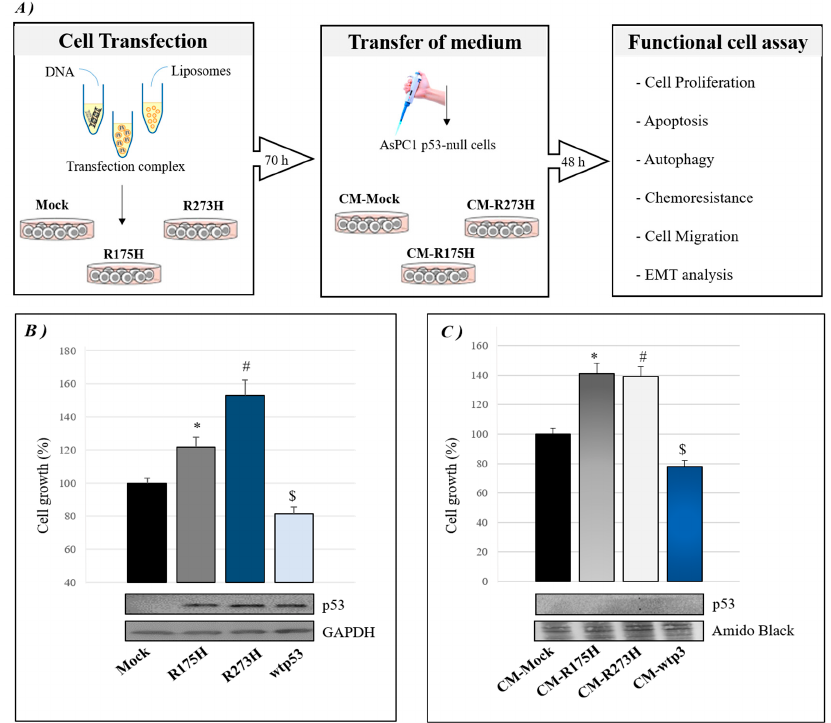
Figure 1. Cancer cell secretome driven by mutant p53 can induce hyper-proliferative effects. ( A ) A summary model of the approach used in this study: p53-null AsPC-1 cells were transfected with plasmids for R273H or R175H mutant p53 over-expression or its mock vector for 48 h. Then, AsPC-1 transfected cells were washed in PBS to remove liposomes and incubated with fresh culture medium for further 22 h to accumulate secreted proteins. After that, the conditioned medium (CM) of AsPC-1 transfected cells was transferred to untransfected p53-null AsPC-1 cells. After 48 h, several biological phenomena listed in the figure were investigated in AsPC-1 cells bearing mutp53-driven CM. ( B ) Cell growth was measured by Cristal Violet assay in p53-null AsPC-1 cells transfected for over-expression of wtp53, R175H or R273H mutp53. Accompanying Western blotting of p53 and of GAPDH for control loading are reported. Statistical analysis * p < 0.05 R175H vs Mock; # p < 0.05 R273H vs Mock; $ p < 0.05 wtp53 vs Mock. ( C ) Cell growth was measured by Cristal Violet assay in untransfected p53-null AsPC-1 cells cultivated with wtp53-, R175H- or R273H-CM. Accompanying Western blotting of p53 and amido black staining are reported. Statistical analysis * p < 0.05 CM-R175H vs CM-Mock; # p < 0.05 CM-R273H vs CM-Mock; $ p < 0.05 wtp53 vs